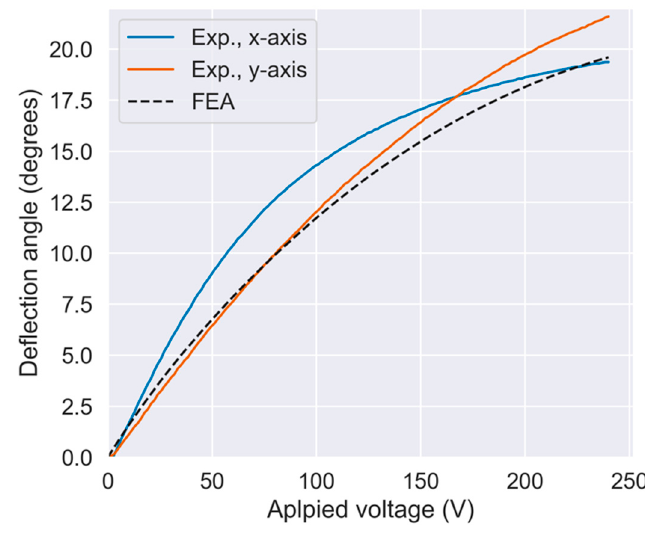
Figure 12. Measured quasi-static actuation characteristics. Table 2. Characteristics of 2-DoF quasi-static scanners.